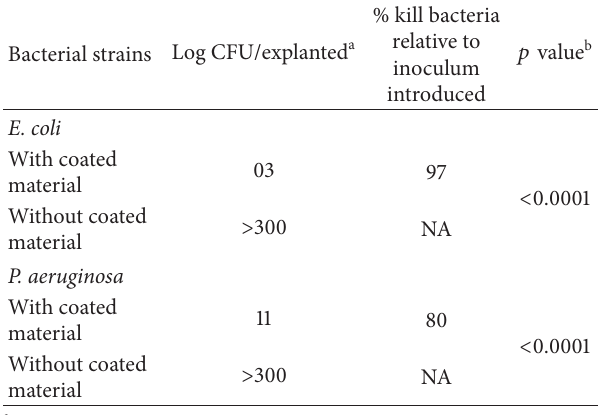
Table 2: In vivo bacterial colonization of suture with coated